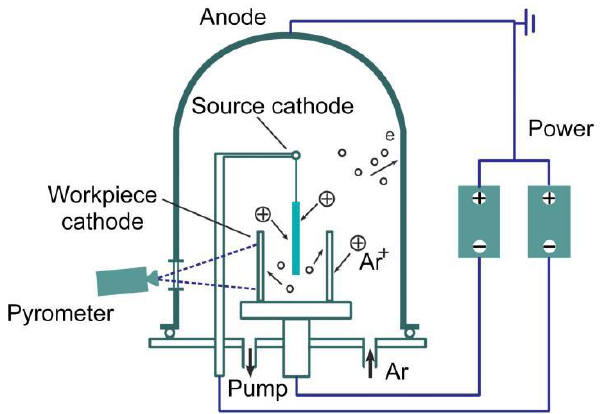
Table 2. Detailed processing parameters of Mo-surface-modified TC4.